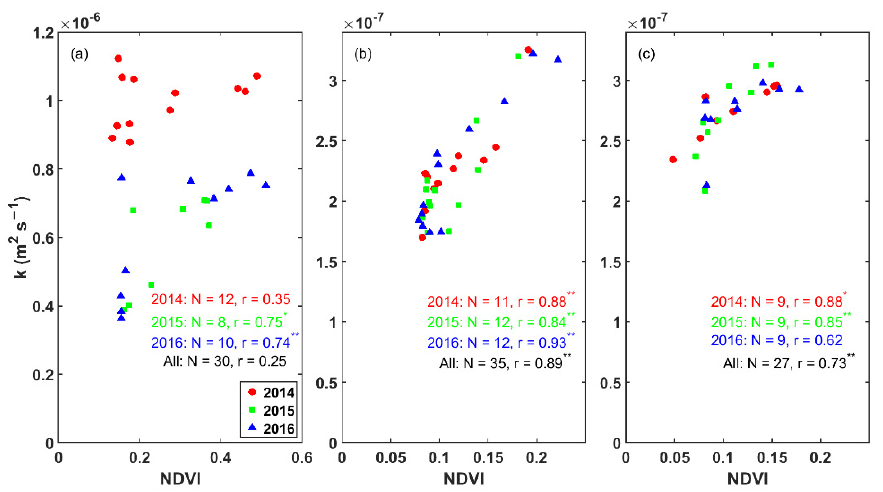
Figure 8. Same as Figure 7, but for the relationship between k and NDVI. “*” indicates p -value < 0.05, “**” indicates p -value < 0.01, and there is no label after r if r is not significant ( p -value > 0.05).